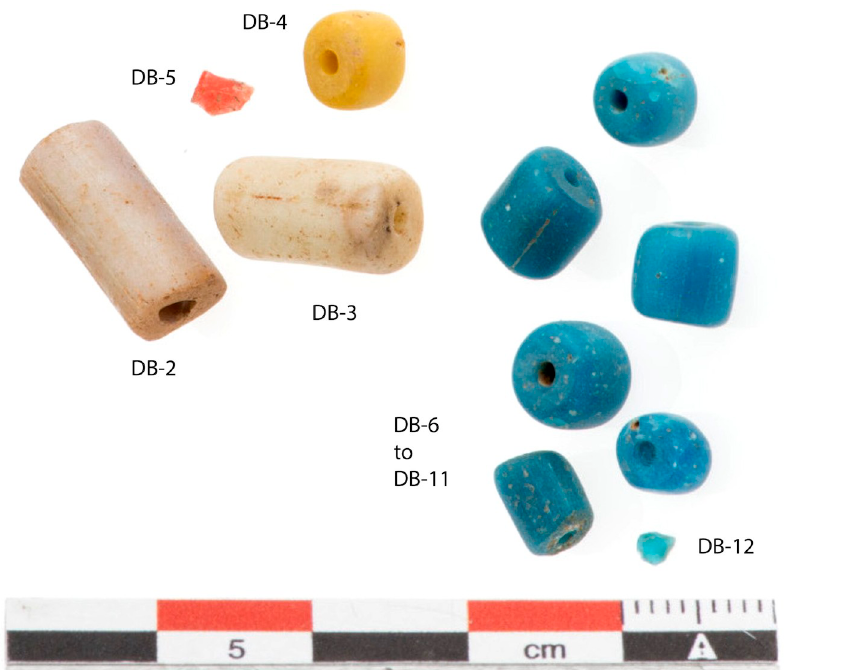
Fig 2. Glass beads found in Dourou-Boro,